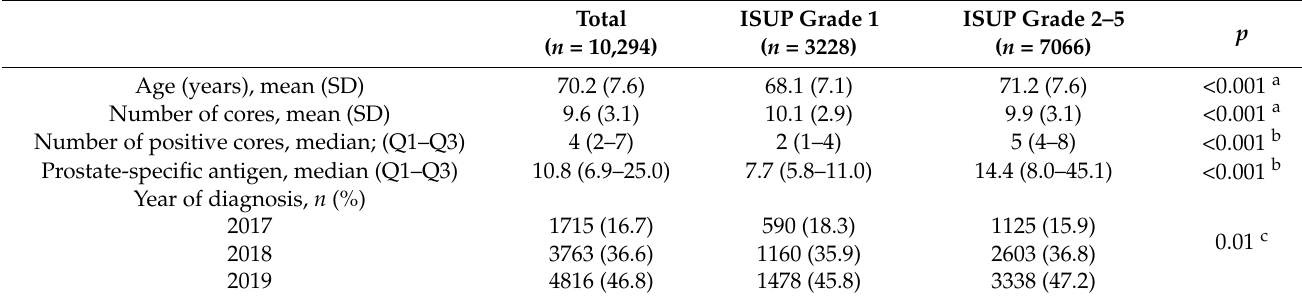
Table 3. Descriptive statistics of the synoptically reported subgroup of patients in a nationwide Dutch cohort of prostate cancer patients analyzed for grading variation.